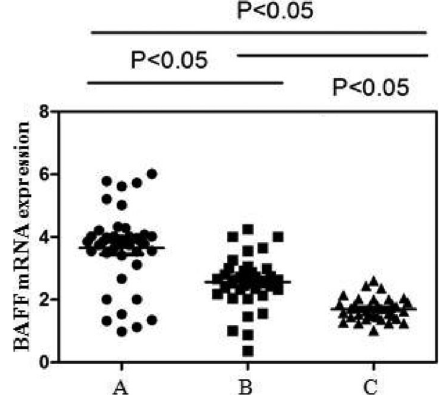
Figure 1. BAFF mRNA expression in PBMCs detected by real- time RT-PCR. A , Active systemic lupus erythematosus (SLE); B , inactive SLE; C , healthy controls. Upregulation of BAFF mRNA expression in PBMCs was 3.92 ± 0.31, 2.58 ± 0.31, and 1.72 ± 0.36, respectively (P o 0.05, Student-Newman-Keuls test).